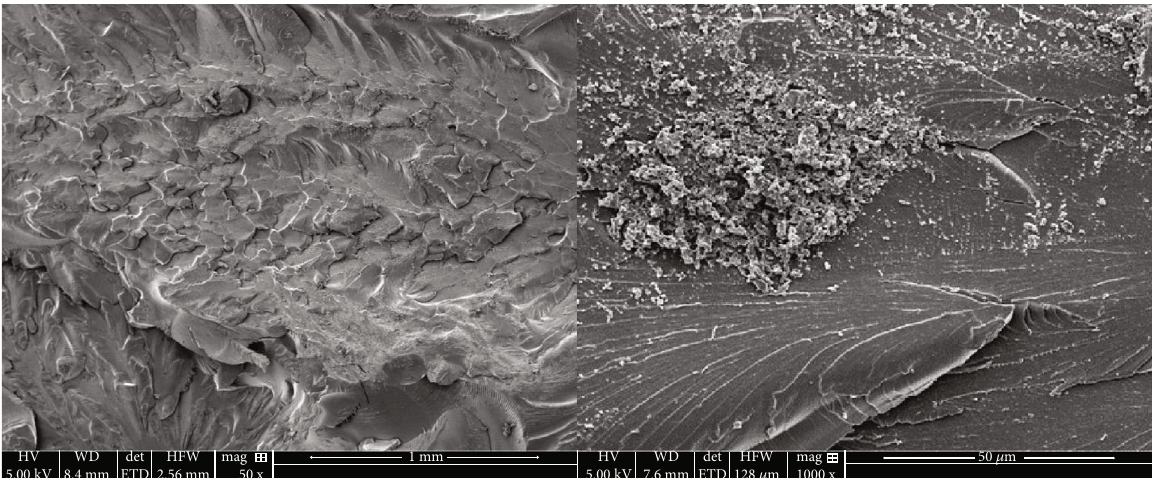
Figure 12: Fracture surfaces due to tensile failure in epoxy at room